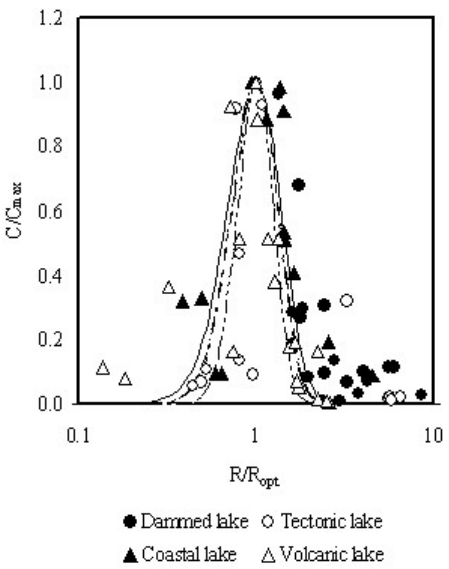
FIGURE 5. Data plots of Chl.a concentrations and TN:TP ratios by Eq. (2) for each lake origin. Each approximation curve is represented by: solid curve for dammed lake ( α = 8.5, r = 0.88), dashed curve for tectonic lake ( α = 11.0, r = 0.69), dash-dotted curve for coastal lake ( α = 11.5, r = 0.80), and dash-double dotted curve for volcanic lake ( α = 18.5, r =